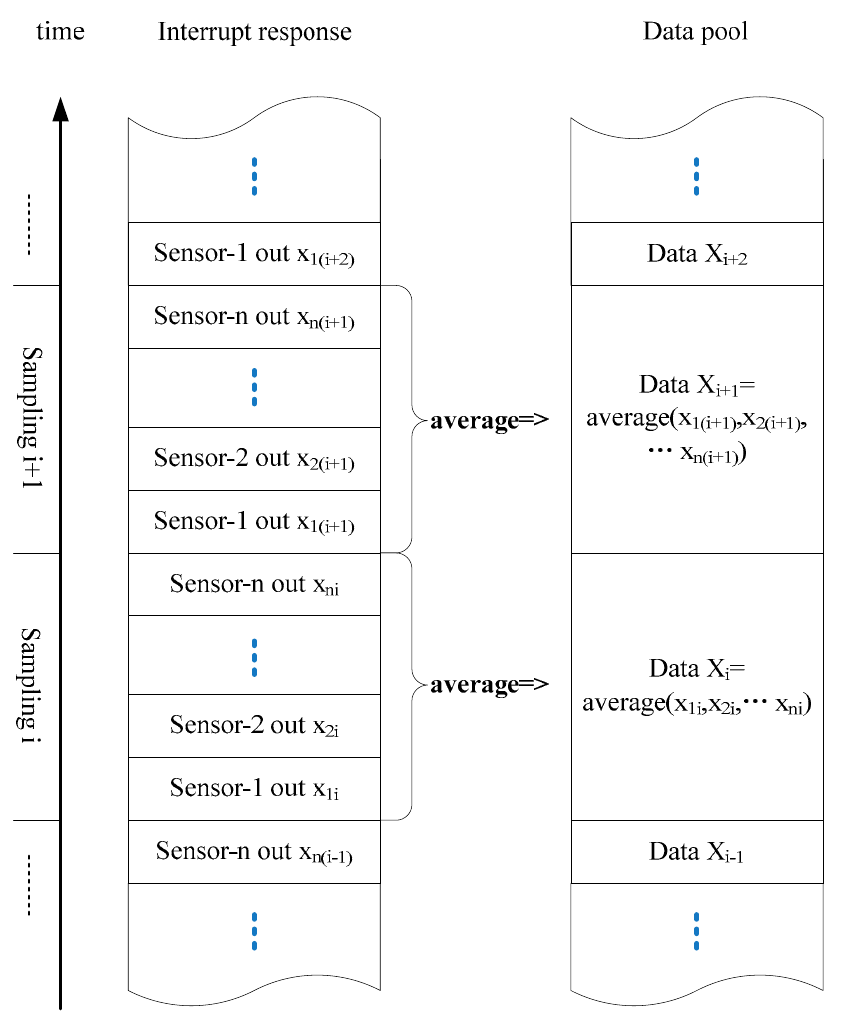
Figure 3. Flowchart representing the data reading and recording process.